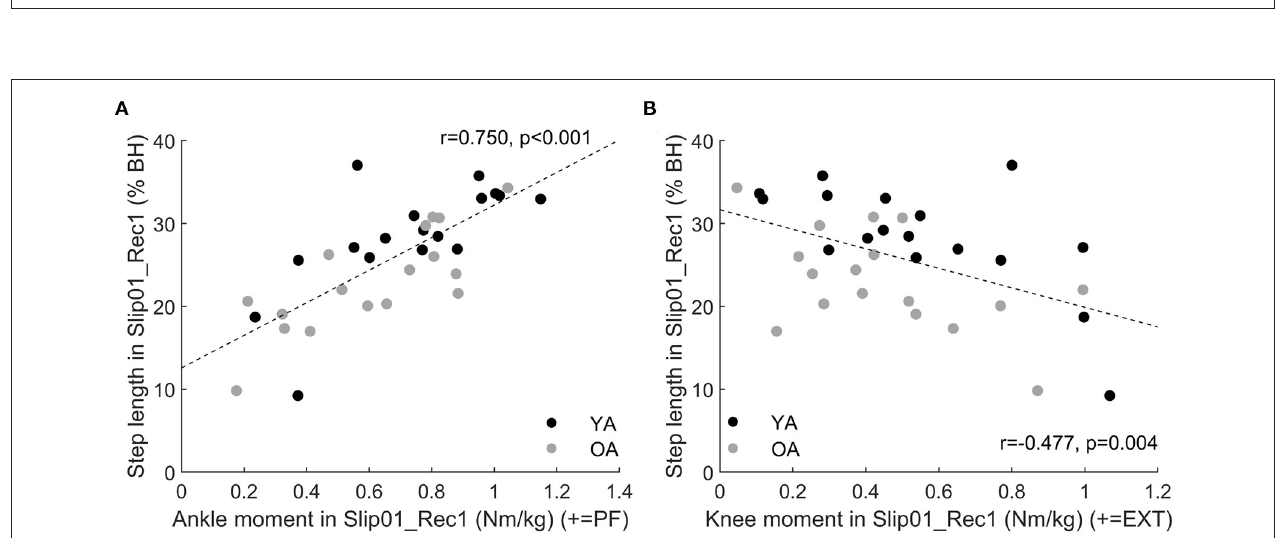
FIGURE 11 | (A) Correlation between ankle moment in Slip01_Rec1 from 37 to 90% stance and step length in Slip01_Rec1 ( r = 0.75, p < 0.001). (B) Correlation between knee moment in Slip01_Rec1 from 23 to 79% stance and step length in Slip01_Rec1 ( r = − 0.477, p = 0.004). Black circles: young adults; grey circles: older adults. % BH: % body